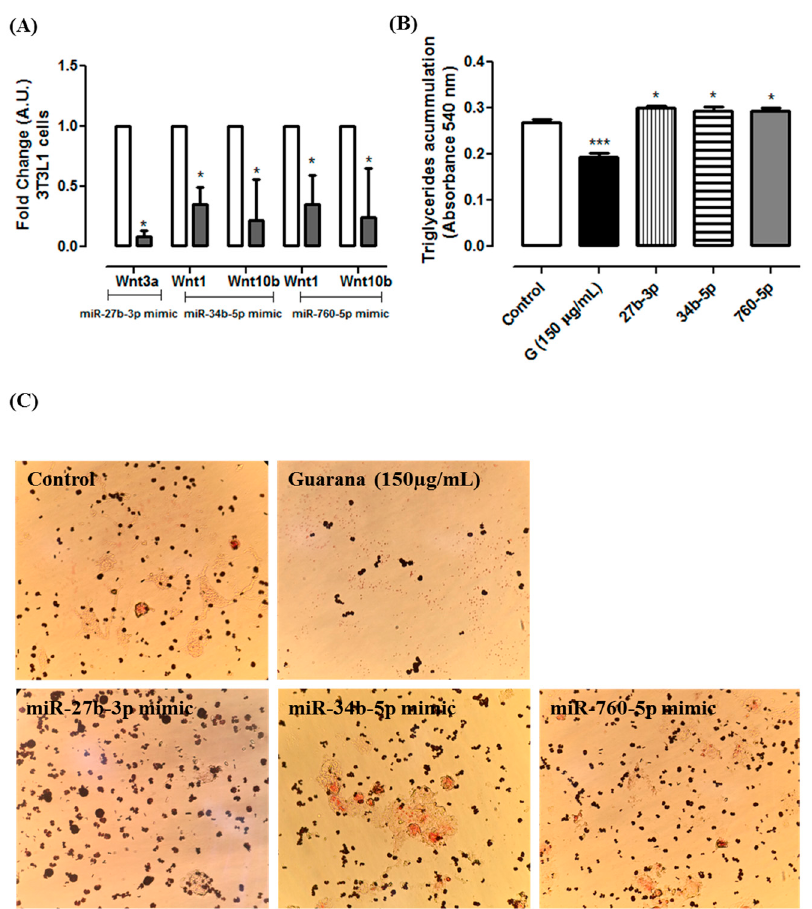
Figure 4. ( A ) Gene expression of Wnt1 , Wnt3a and Wnt10b in 3T3L1 cells transfected with mmu-miR-27b-3p, mmu-miR-34b-5p or mmu-miR760-5p mimics after 96 h of differentiation. White bars corresponding to Control and grey bars corresponding to 3T3L1 transfected with mmu-miR-27b-3p, mmu-miR-34b-5p or mmu-miR760-5p mimics. * Significative down-regulation was considered when the fold change was ≤− 0.5 for microRNA expressions and ≤− 0.6 for mimic experiment; ( B ) Triacylglycerol accumulation in 3T3-L1 cells transfected with mmu-miR-27b-3p, mmu-miR-34b-5p or mmu-miR760-5p mimics according to Oil Red O assay. Control (C+)—cells cultivated with differentiation medium; Guarana (150 µ g/mL)—cells cultivated with differentiation medium + guarana (150 µ g/mL) during 96 h; 27b-3p, 34b-5p and 760-5p—cells transfected with mmu-miR-27b-3p, mmu-miR-34b-5p or mmu-miR760-5p (respectively) cultivated with differentiation medium. * p < 0.05 and *** p < 0.01 compared to Control; ( C ) Illustrative images of Oil Red O in 3T3L1 cells Control, Guarana (150 µ g/mL) and transfected with mmu-miR-27b-3p, mmu-miR-34b-5p or mmu-miR760-5p mimics (magnification = 200 ×).